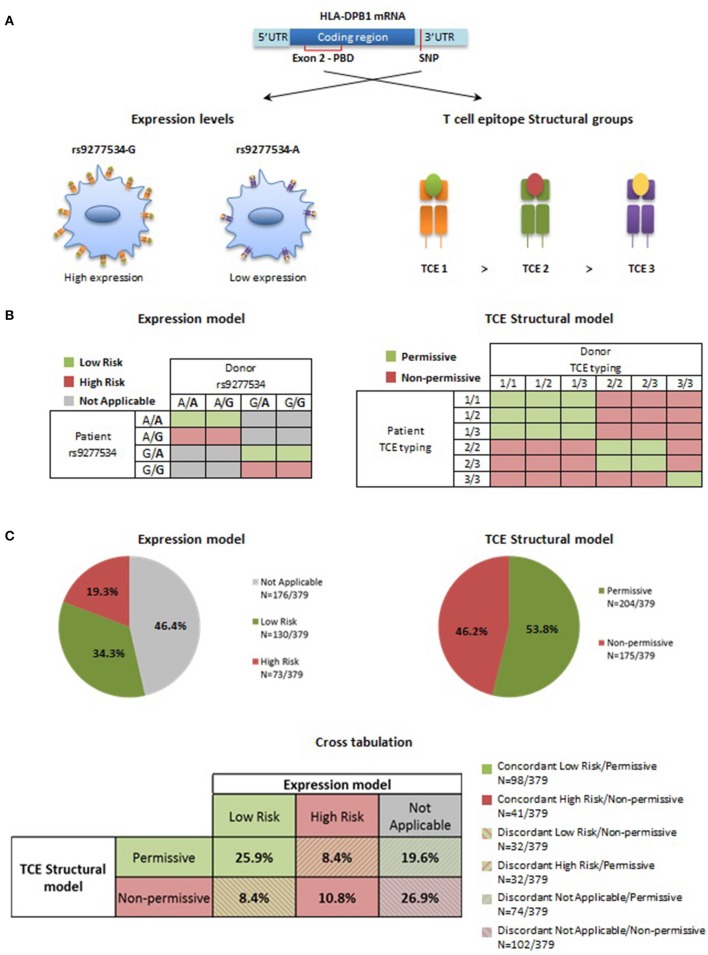
Expression model and TCE Structural model for HLA-DPB1 mismatches in HSCT. (A) Genetic control of HLA-DP expression levels is mediated by the biallelic SNP rs9277534, with a high expression G- and a low expression A-variant (5). Three distinct TCE groups with decreasing immunogenicity are determined by structural amino acid variability in the peptide binding domain (PBD) encoded by exon 2 in the HLA-DPB1 coding region (9, 15). (B) For Expression matching, only truly single HLA-DPB1 allele mismatches in GvH direction are considered, leading to a number of combinations that cannot be classified (in gray). For the others, favorable (low risk, in green) and unfavorable (high risk, in pink) pairs are those where the mismatched allele in the patient carries the low expression rs9277534-A or the high expression rs9277534-G variant, respectively (8). For TCE Structural matching, favorable (permissive, in green) pairs are those in which patient and donor share at least one HLA-DPB1 allele from the TCE group with the highest immunogenicity; the others are predicted to be unfavorable (non-permissive, in pink) (9, 11). (C) Percentage of favorable and unfavorable HLA-DPB1 mismatches according to the Expression model or the TCE Structural model in 379 donor-recipient pairs from the University Hospital Essen. Pies indicate the percentage of favorable (low risk or permissive, in green) or unfavorable (high risk or non-permissive, in pink) combinations according to the two models, or of pairs that cannot be classified by the Expression model (not applicable, gray). Classification by the two models has a 36.7% concordance (filled boxes in the cross-tabulation), and 63.3% discordances (striped boxes in the cross-tabulation), either due to differential risk assignment (background green or pink) or to non-applicability of the Expression model (background gray).